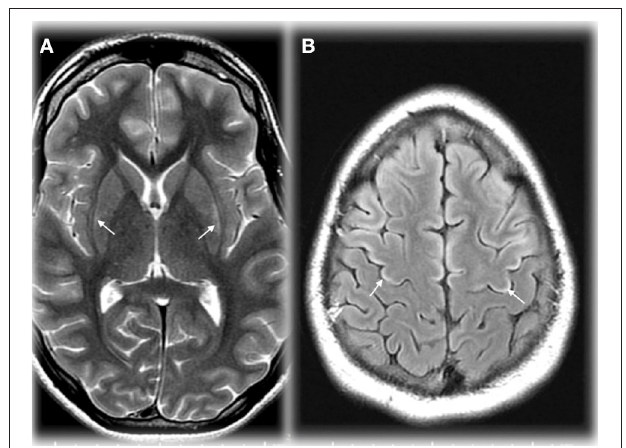
FIGURE 2 | Axial T2 weighted image (TR/TE ms, 4,228/98) through the basal ganglia (A) demonstrating maximal changes in signal in the lateral putamen in an adolescent in OTCD after HA. Axial T2 FLAIR image (IT/TR/TE ms, 2,250/10,000/144) at the cerebral vertex (B) showing cortical hyperintensity in parts of the frontal lobes (motor strip, arrows). Reprinted from, with permission from IOS Press. Sen et al. ( 62).